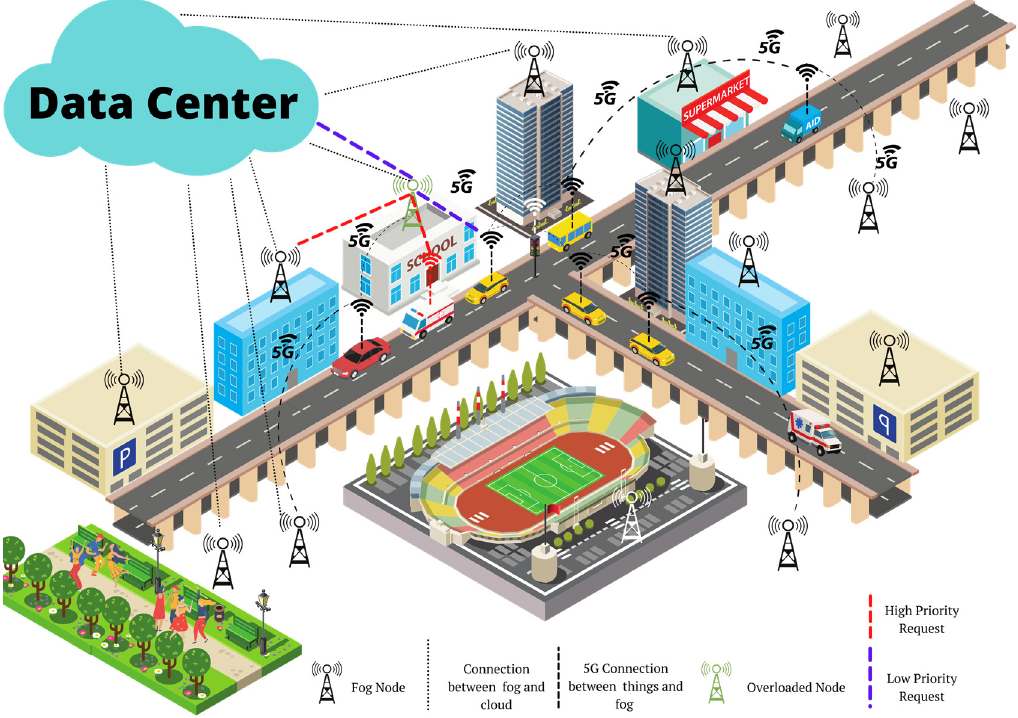
Figure 3. Graphical representation of proposed model.